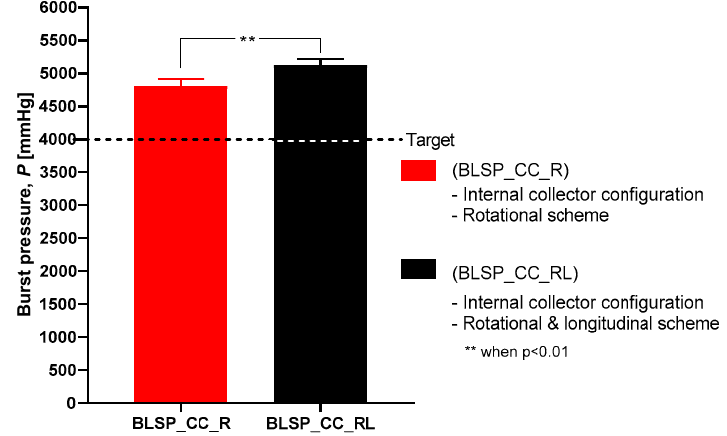
Figure 18. Burst pressure strength.